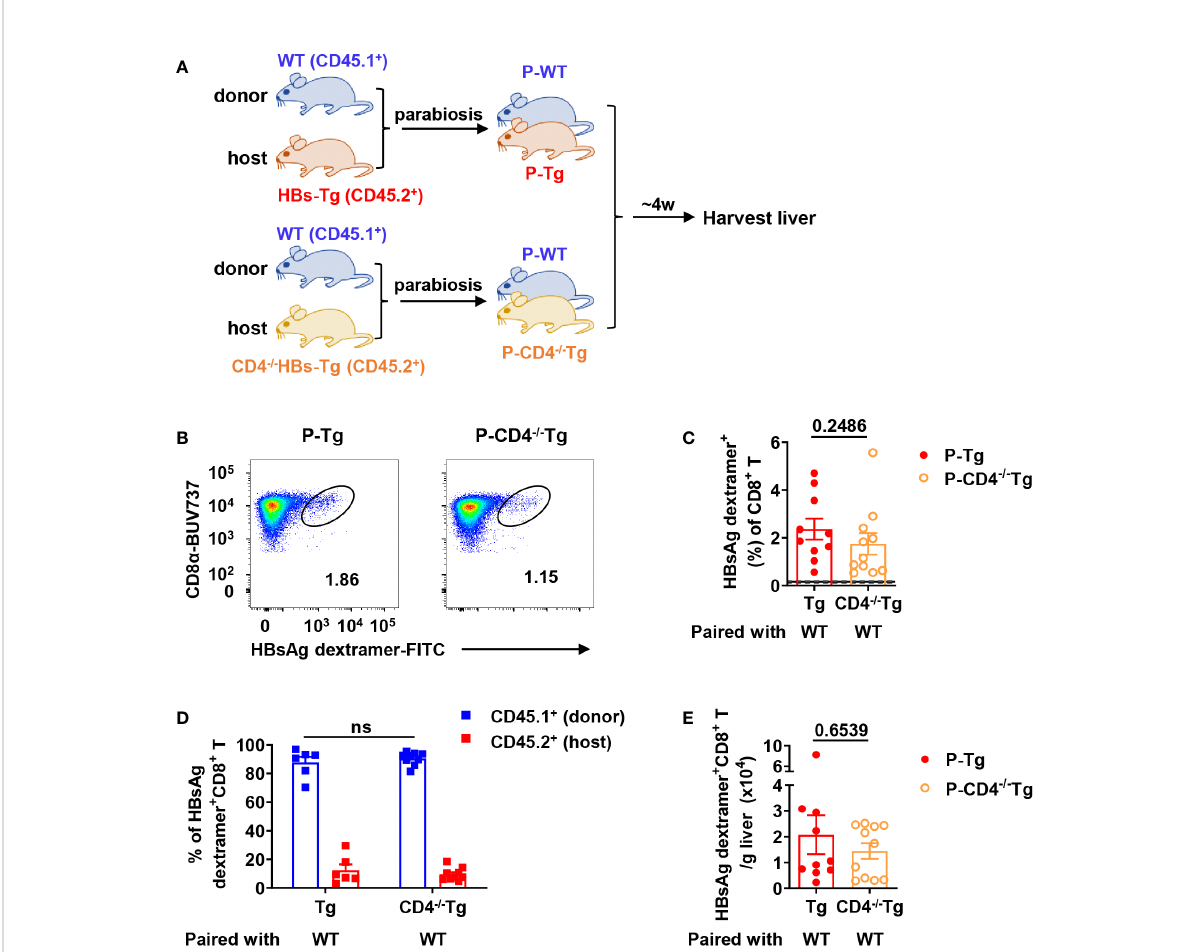
FIGURE 7 Donor HBsAg-speci fi c CD8 + T cells were still generated in CD4 -/- HBs-Tg parabionts paired with WT mice. CD4 -/- HBs-Tg mice (CD45.2 + ) were surgically conjoined with WT mice (CD45.1 + ) to generate WT-CD4 -/- HBs-Tg parabiotic mice. Four weeks after surgery, parabiotic mice were separated and liver samples were harvested from each group. Intrahepatic MNCs were isolated for fl ow cytometry analysis. (A) Protocol for the model of WT-CD4 -/- HBs-Tg parabiotic mice (schematic). (B) Representative plots showing the frequency of HBsAg dextramer + CD8 + T cells in the liver of each group. (C) The frequency of HBsAg dextramer + CD8 + T cells in the liver of P-CD4 -/- Tg (paired with WT), compared with P-Tg (paired with WT). The data ranging in 95% con fi dence interval (CI) (0.16% ± 0.04%, as described in Figure 3B) were considered negative. (D) The proportion of CD45.1 + (donor) or CD45.2 + (host) in HBsAg dextramer + CD8 + T cells from the liver of P-CD4 -/- Tg, compared with P-Tg. (E) The number of HBsAg dextramer + CD8 + T cells in the liver of P-Tg and P-CD4 -/- Tg. The Mann-Whitney test was used (C, E) . Two-way ANOVA with Sidak ’ s multiple comparison test was used (D) . Data are shown as mean ± SEM. The numbers between the bars show the p-values. ns, not signi fi cant. P-Tg, HBs-Tg parabiont; P-CD4 -/- Tg, CD4 -/- HBs-Tg